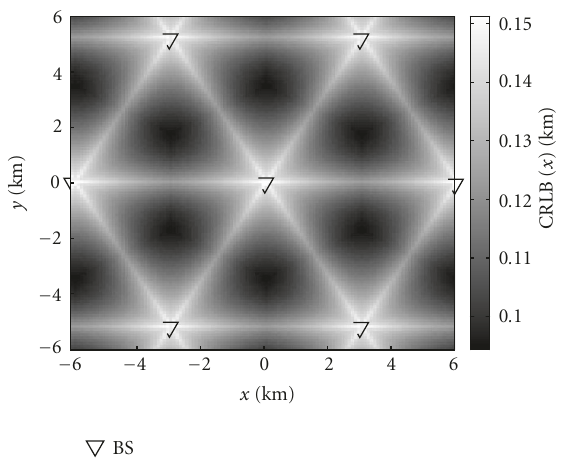
Figure 7: CRLB( x ) for σ n = 0.1 km, R = 3 km, N BS = 3.